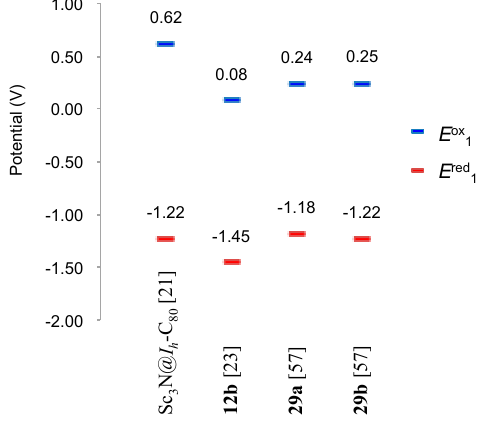
Figure 4. Redox potentials (in V vs. Fc/Fc + ) of pristine and derivatized Sc 3 N@ I h -C 80 .